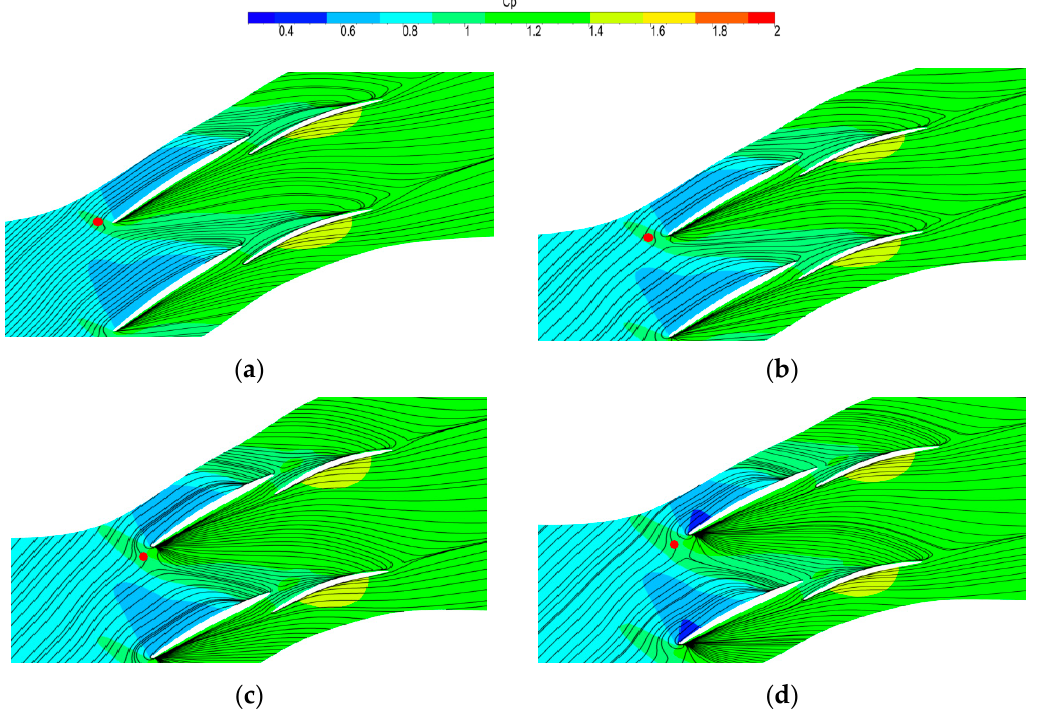
Figure 20. Comparison of flow line and static pressure diagram on the hub wall of PB10, PB20, and PB30. ( a ) ORG. ( b ) PB10. ( c ) PB20. ( d )